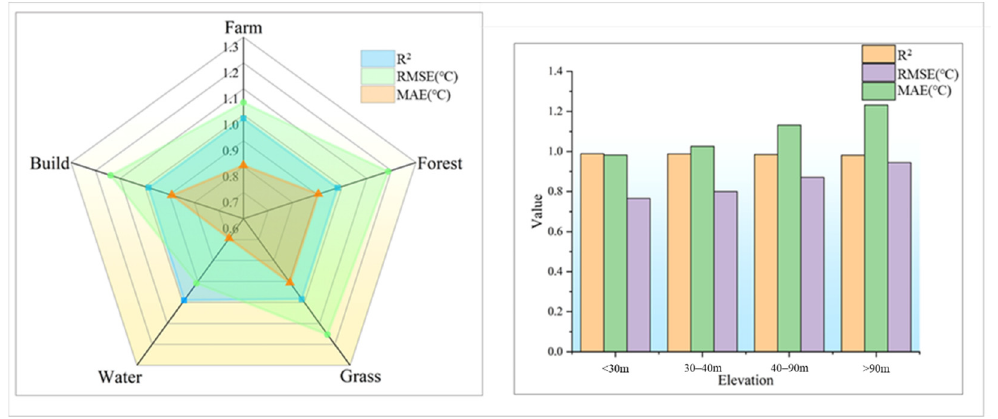
Figure 13. Model performance in different land cover types (on the left ) and ranges of elevation (on the right ).